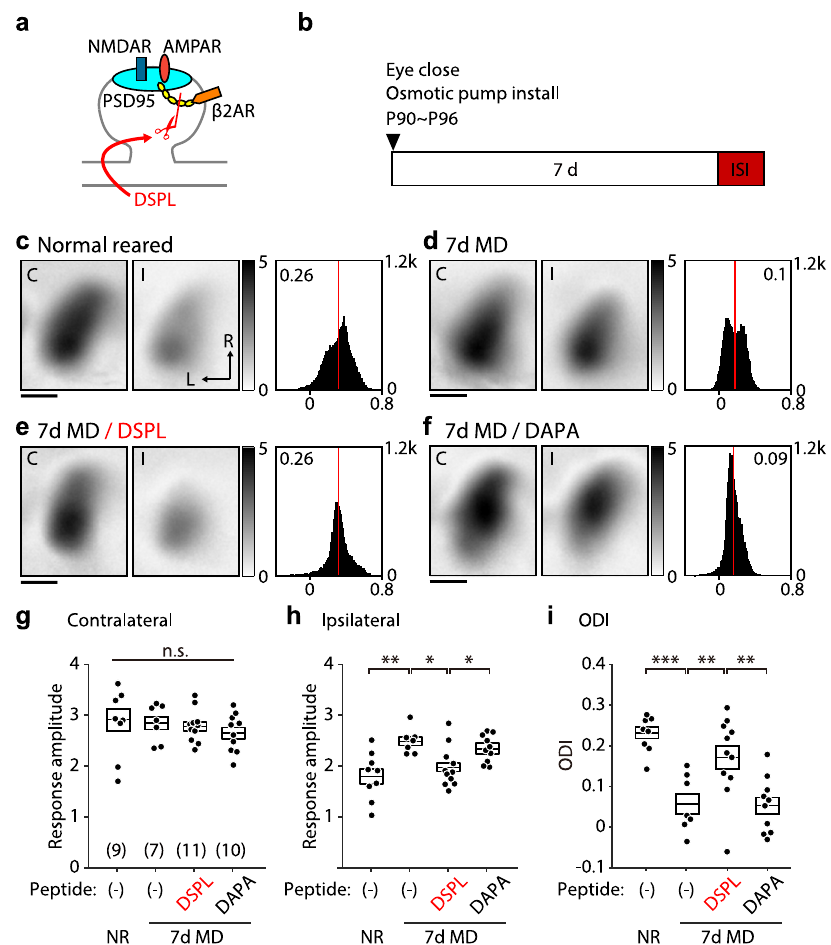
Fig. 6 Blockage of the conversion of the LTP trace impairs the ocular dominance plasticity in young adult mice. a A diagram illustrating that DSPL disrupts the direct interaction of the β 2-adrenergic receptor with PSD-95. b Experiment timeline. For the MD, the contralateral eye to the recorded hemisphere was closed for 7 days before the ISI. Peptide infusion was started when the eye closed. c – f Representative visual cortical response of the mouse normal reared ( c ), after 7 days of MD ( d ), after 7 days of MD with the infusion of DSPL ( e ), and after 7 days of MD with the infusion of the control peptide, DAPA ( f ). Left and middle: each magnitude map shows the visual cortical response from the contralateral (C) or the ipsilateral (I) eye from the recorded hemisphere. Gray scale: response amplitude as the fractional change in re fl ection ×10 4 . Arrows: L, lateral, R, rostral. Right: histogram of the ODI illustrated in the number of pixels ( x -axis: ODI, y -axis: number of pixels). g – i Summary of the response amplitude evoked by the contralateral ( g ) and ipsilateral ( h ) eye as well as the ODI ( i ) of each group. Box plot: average ± s.e.m. One-way ANOVA and post hoc Holm – Sidak ’ s multiple comparison test, g F (3,33) = 0.578, p = 0.633; h F (3,32) = 6.267, p = 0.001; i F (3,33) = 12.31, p < 0.001; * p < 0.05, ** p < 0.01, *** p < 0.001. Source data are provided as a Source Data fi